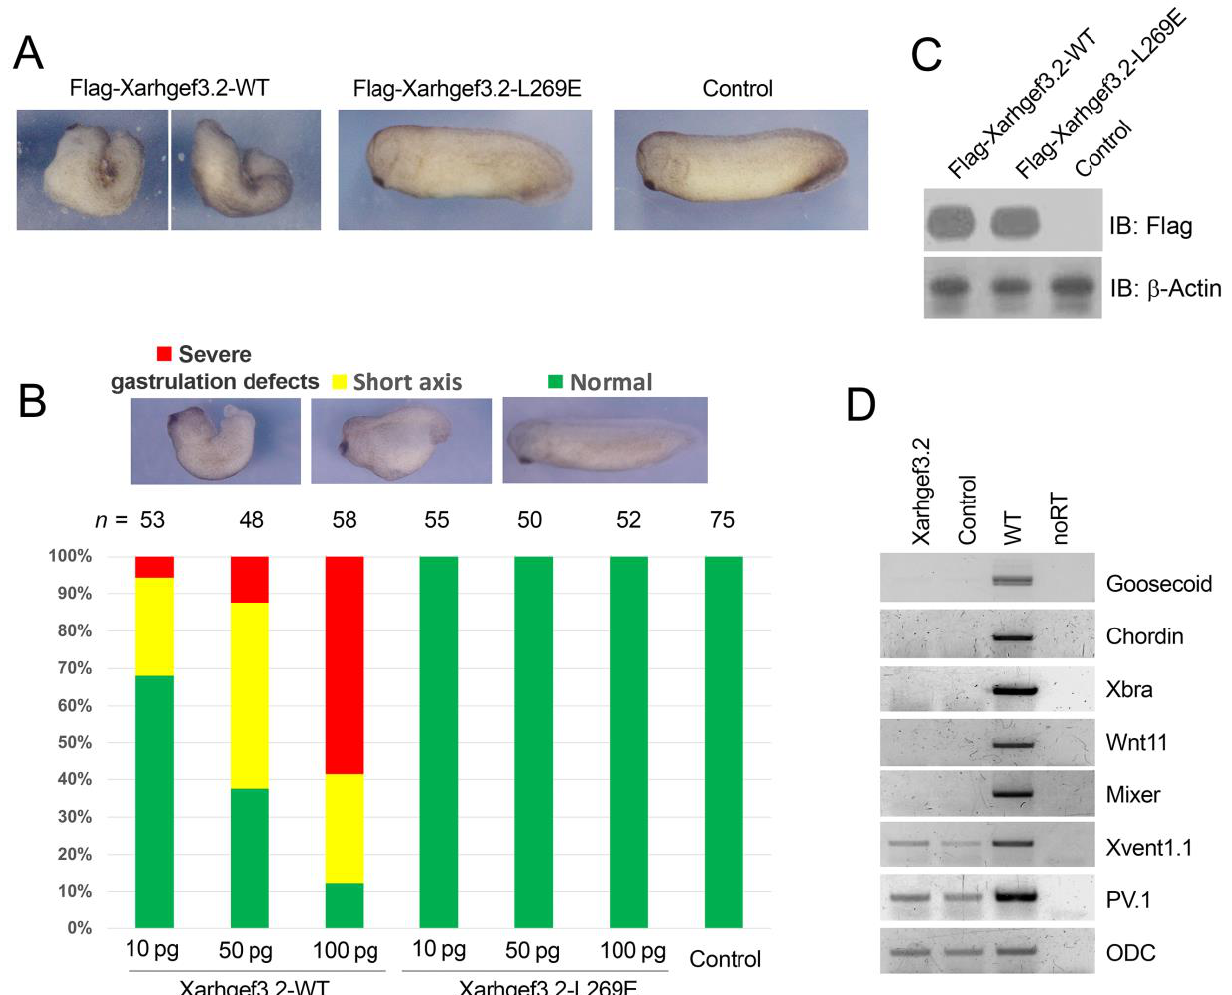
Figure 3. Overexpressed Xarhgef3.2 induces gastrulation defects of Xenopus embryos. ( A ) RNAs of WT-Xarhgef3.2 or MT-Xarhgef3.2 (L269E) were injected into the animal pole region at the one-cell stage (100 pg/embryo). ( B ) RNAs of Flag-Xarhgef3.2 (100 pg/embryo) or Flag-Xarhgef3.2 (L269E) (100